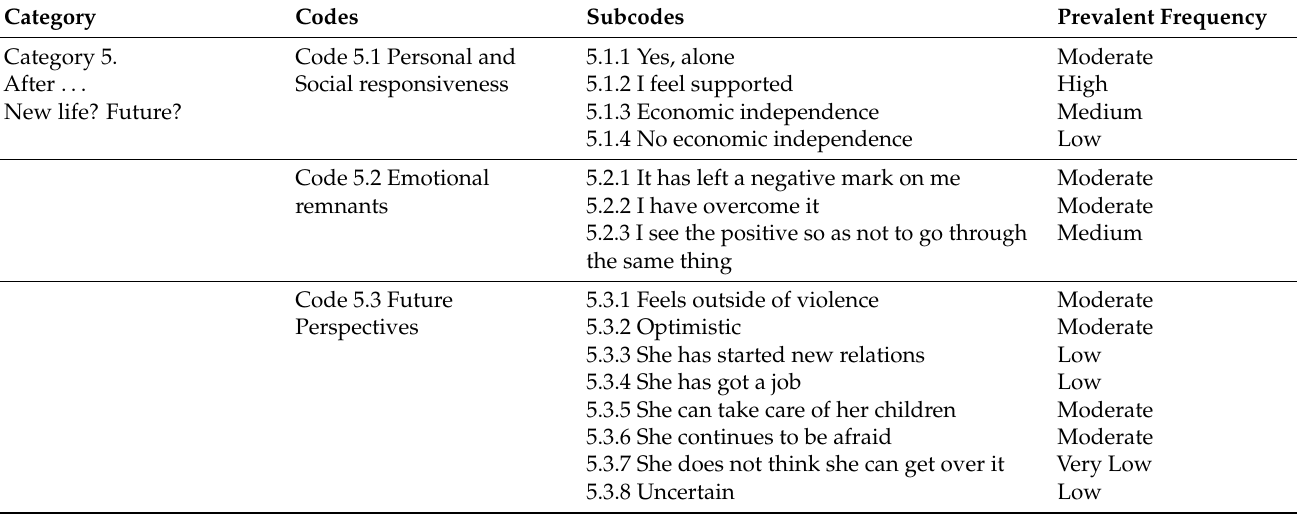
Table 5. Category